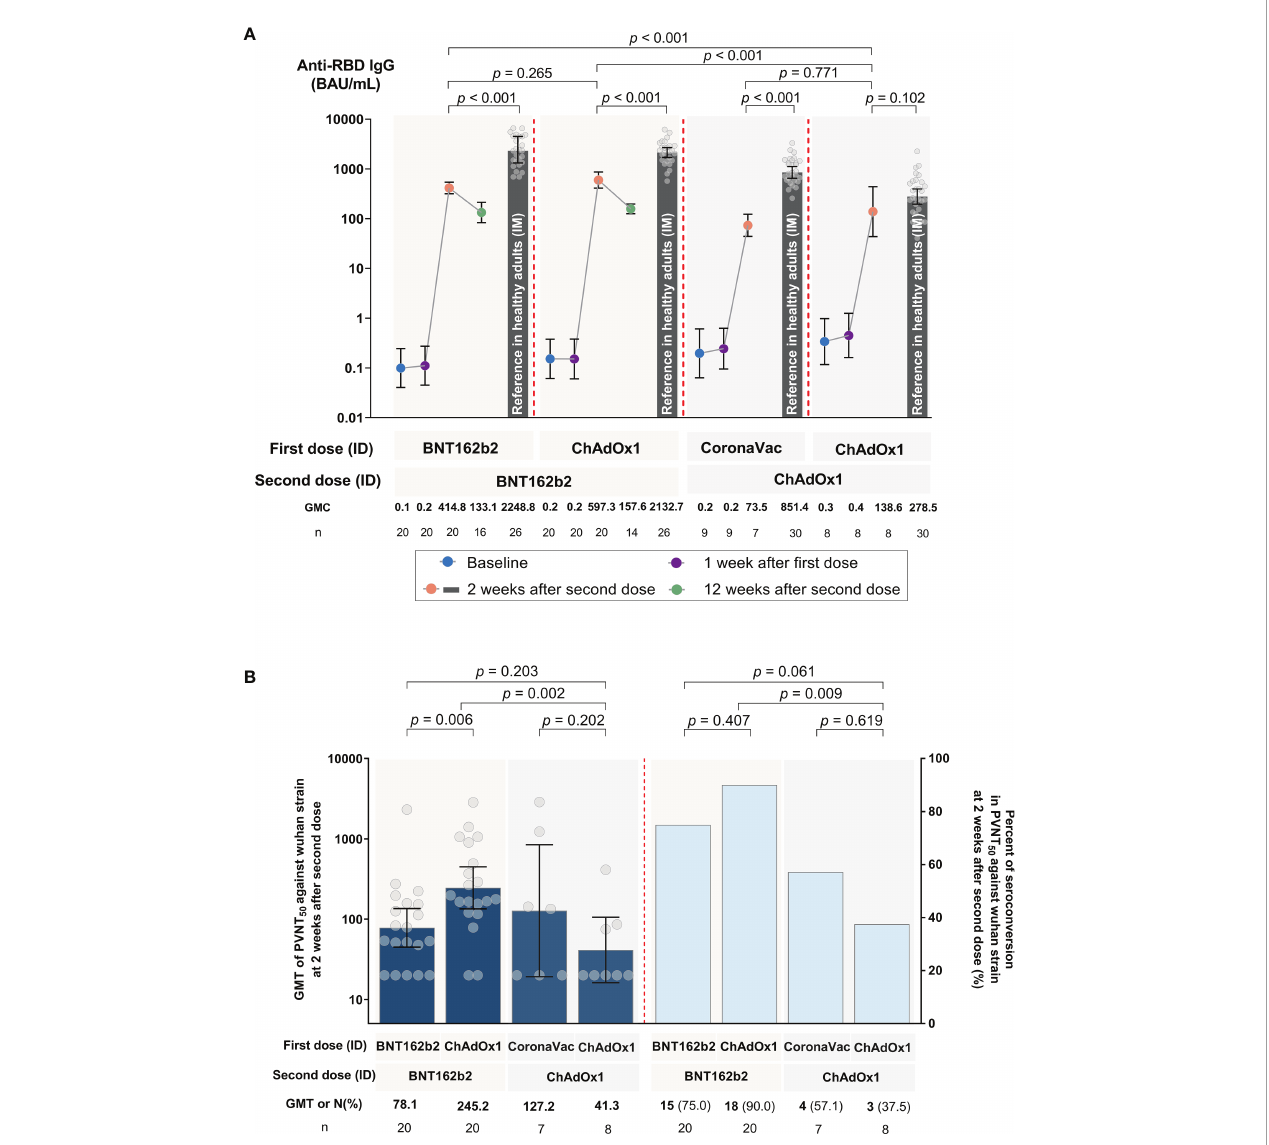
FIGURE 2 SARS-CoV-2 humoral immune responses against the ancestral Wuhan strain following accelerated regimens of fractional, ID administration. (A) SARS- CoV-2 RBD IgG at baseline, 1 week after the fi rst dose, and 2 weeks after the second dose for Groups 1 to 4, as well as 12 weeks after the second dose for Groups 1 and 2. The reference bars represent the results for conventional intramuscular (IM) routes of each respective COVID-19 vaccine regimen, as obtained from a previous study (15). (B) Pseudovirus neutralization tests (PVNT 50 , shown in dark blue) and percent seroconversion (shown in blue bars) 2 weeks after the second dose. Error bars represent geometric means (GMs) and 95% con fi dence intervals